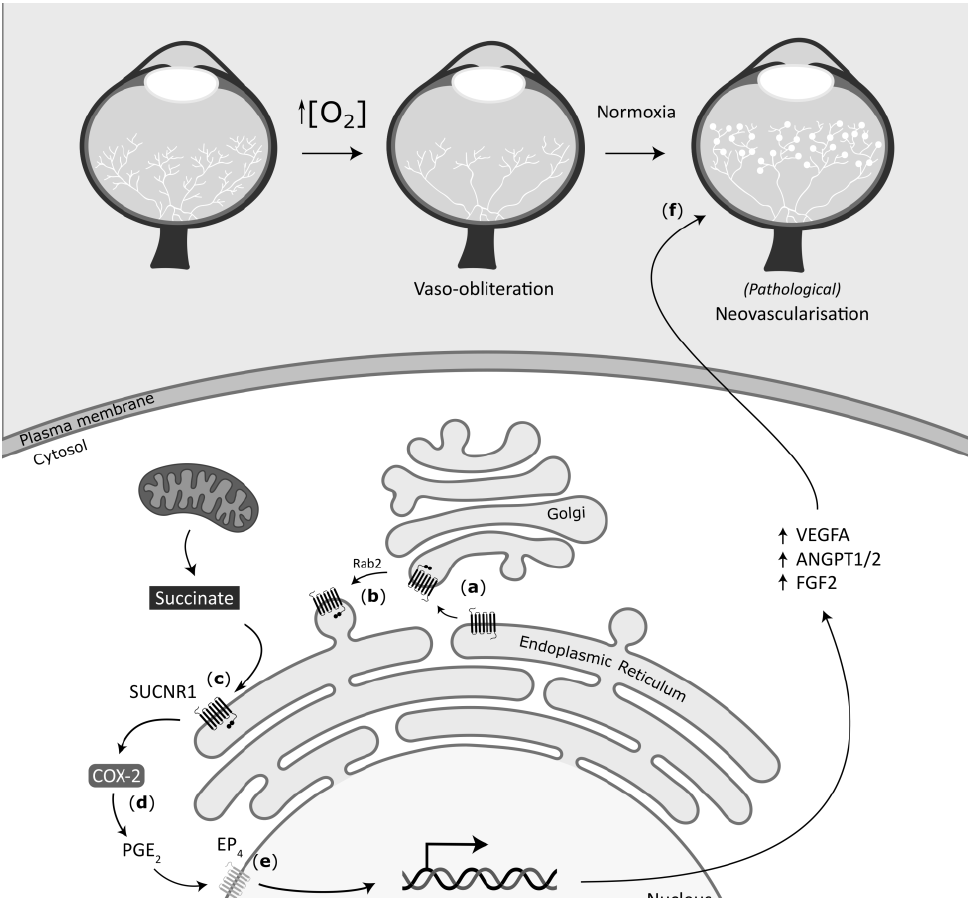
Figure 7. Schematic depiction of the angiogenesis mechanism induced by SUCNR1 stimulation. The top depicts the OIR model. When the retina is exposed to high O 2 concentrations during development, a remarkable vaso-obliteration occurs, which, upon return to normoxic conditions, provokes local hypoxia. In this context, our proposed model of SUCNR1 signaling is: ( a ) SUCNR1 proper folding begins during translation at the ER, with glycosylation taking place along the ER-to-Golgi axis. ( b ) Upon proper glycosylation, RAB2-mediated SUCNR1 retrograde transport targets the receptor to the ER. ( c ) Upon increased energetic demands (hypoxia, intense exercise), succinate accumulates in the cytoplasm and stimulates SUCNR1. ( d ) SUCNR1 signals downstream through an interaction with COX-2, in turn leading to PGE 2 production. ( e ) PGE 2 stimulates the EP 4 receptor, which subsequently triggers transcription of proangiogenic genes. ( f ) Higher proangiogenic gene expression leads to neovascularization; in prolonged hypoxic conditions where SUCNR1 localizes to the plasma membrane, disturbed expression of proangiogenic genes, notably lesser VEGFA expression, may be a factor driving the pathological “tufts”